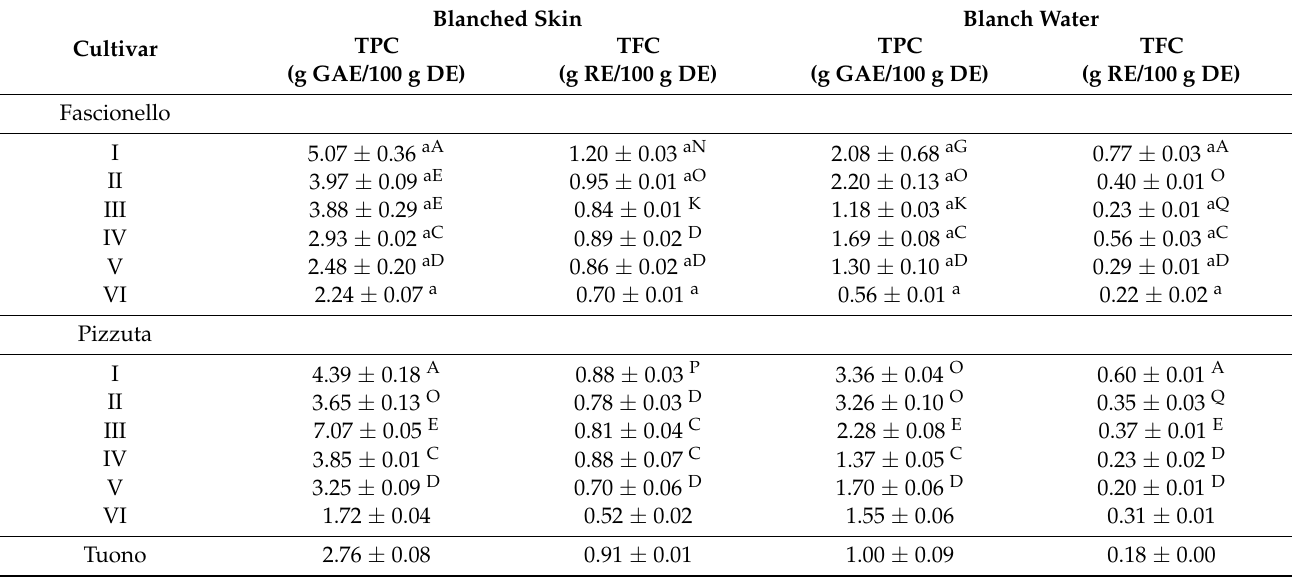
Table 3. Total phenols and flavonoids contents (TPC and TFC, respectively) quantified by in vitro colorimetric assays. Results, which represent the average ± standard deviation of three independent experiments in triplicate ( n = 3), were expressed as gallic acid and rutin equivalents (GAE and RE, respectively)/100 g of dried extract (DE). Numbers from I to VI represent different producers.